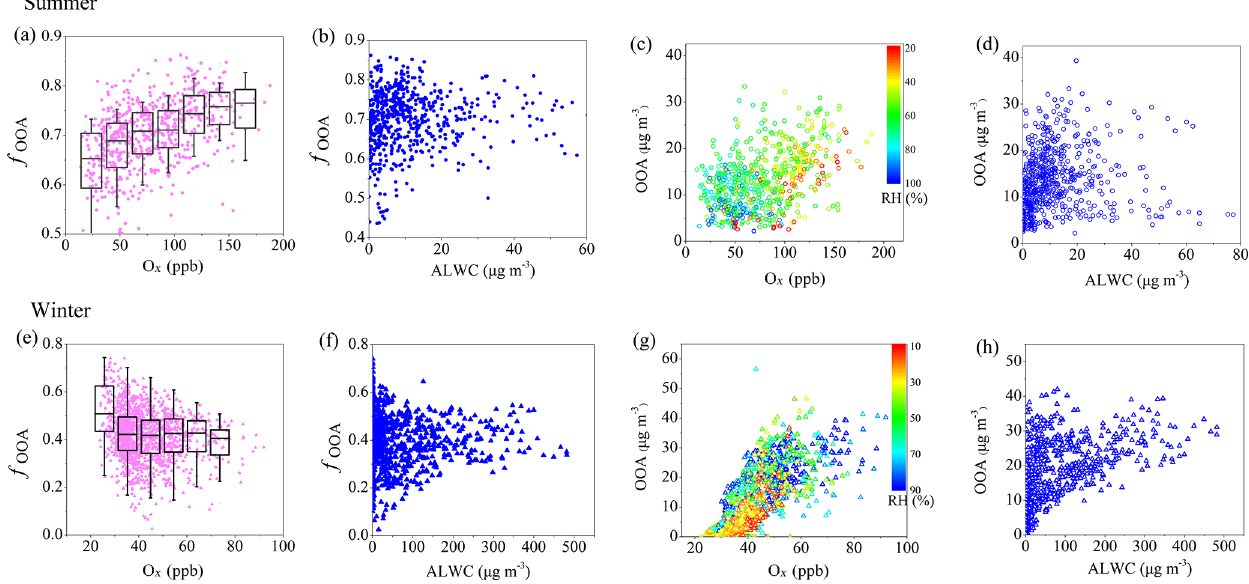
Figure 5. Scatterplots of f OOA (mass fraction of OOA (related to OOA in summer and the total of LO-OOA + MO-OOA in winter) to OA) and mass concentration of OOA versus O x and ALWC in summer (a–d) and winter (e–h)